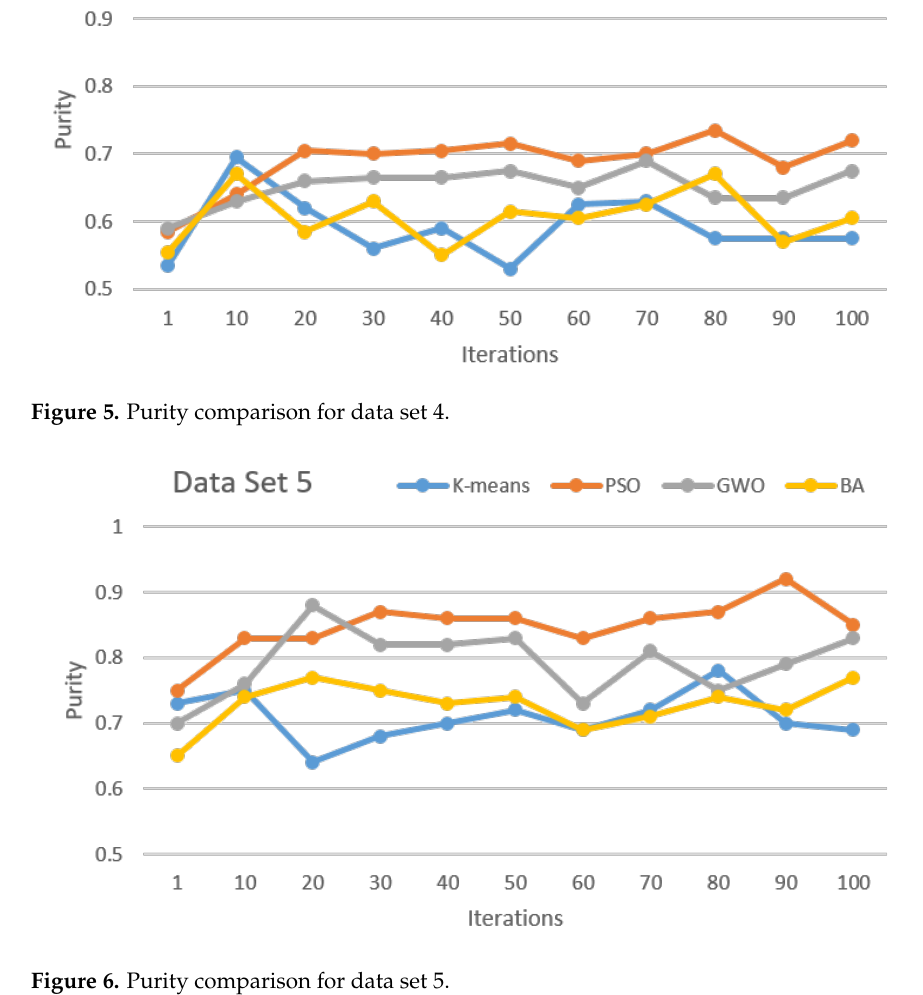
Figure 6. Purity comparison for data set 5.